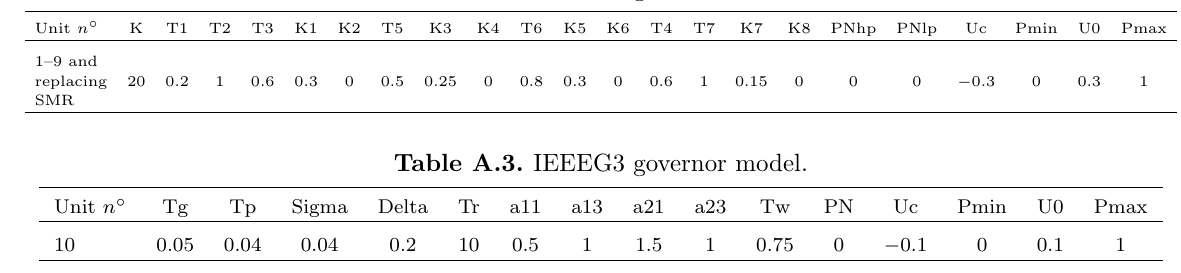
Table A.2. IEEEG1 governor model.